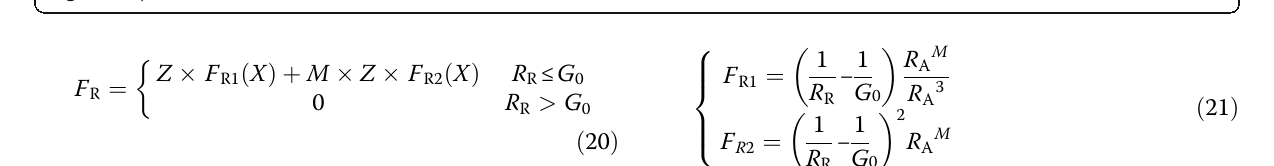
Fig. 7 Analysis of forces on a robot